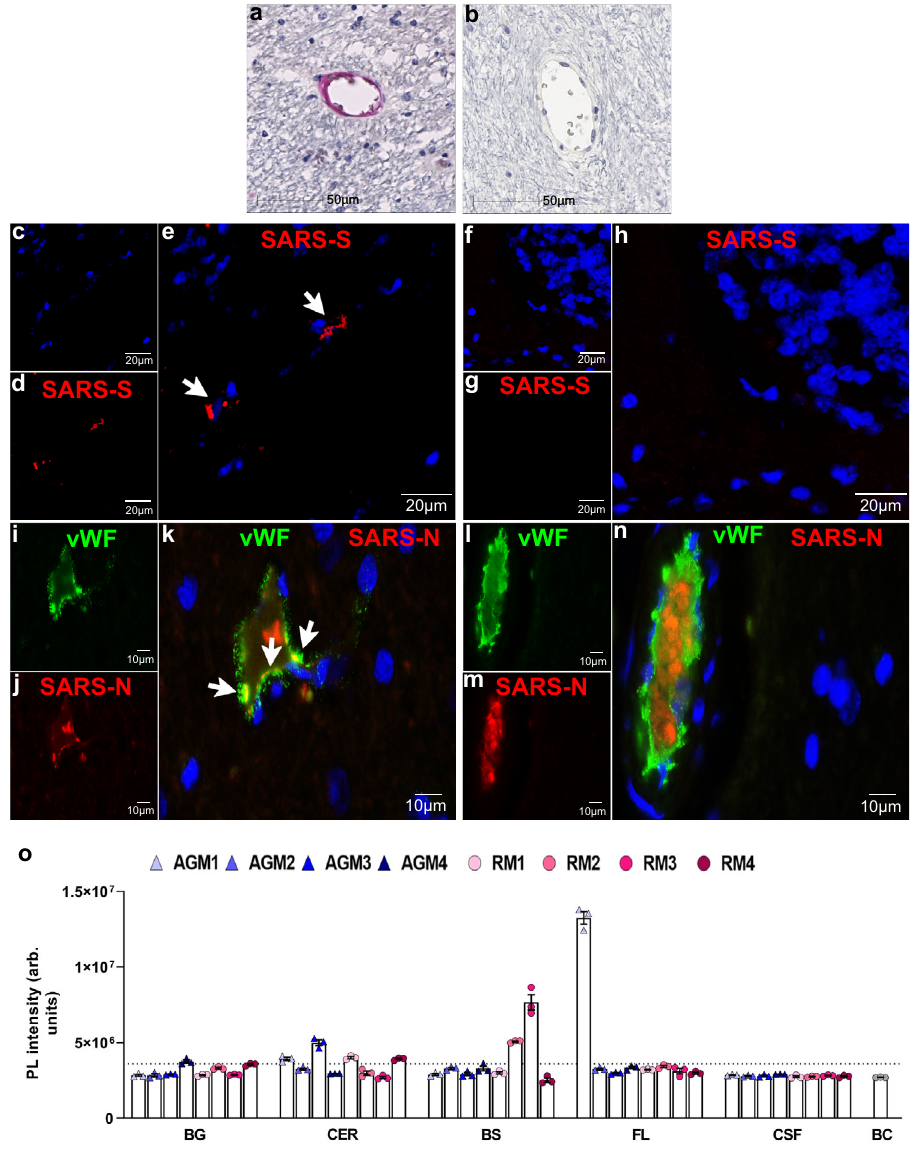
Fig. 6 SARS-CoV-2 detection in the brain. Representative single-label IHC shows infrequent SARS-CoV-2 nucleocapsid (SARS-N) positivity in a cerebellar blood vessel of RM1 ( a ). Positivity was not detected in non-infected controls (AGM6 cerebellum b). SARS-CoV-2 spike (SARS-S) mRNA expression was assessed with in situ hybridization (RNAscope) but not seen in control animal tissue (RM6 cerebellum f - h ). Rare positivity was seen in infection (AGM1 cerebellum c – e ). RNAscope was performed 7 times on the brain regions investigated. A majority of brain tissue does not show any virus in infected animals which can be seen in the neighboring vessel (RM3 basal ganglia l – n ) to a vessel with suggestive virus positivity ( i – k ). Endothelial cell infection is suggested by double fl uorescent labeling of SARS-N with von Willebrand factor (vWF) (RM3 basal ganglia i – k ). Merged images show colocalization of SARS-N (red; j ) with vWF (green; i ), indicated by white arrows. Blue color represents DAPI labeled cell nuclei. Immunohistochemical staining for SARS-N was performed 12 times on the brain regions investigated. SARS-CoV-2 RNA was detected in the different brain regions of infected animals via a CRISPR-based fl uorescent method ( o ) where n = 3 repeats of independent samples. Dotted line indicates the cut-off value of positivity equal to 3.6 × 10 6 photoluminescence (PL) intensity. Data are expressed as mean ± SEM. Source data are provided as a Source Data fi le. Abbreviations: BG basal ganglia, CER cerebellum, BS brainstem, FL frontal lobe, CSF cerebrospinal fl uid, BC blank control, arb. units arbitrary units, AGM African green monkey, RM Rhesus macaque. Scale bars = 50 µ m ( a and b ), 20 µ m ( c – h ), and 10 µ m ( i – n ). Fluorescence images are at